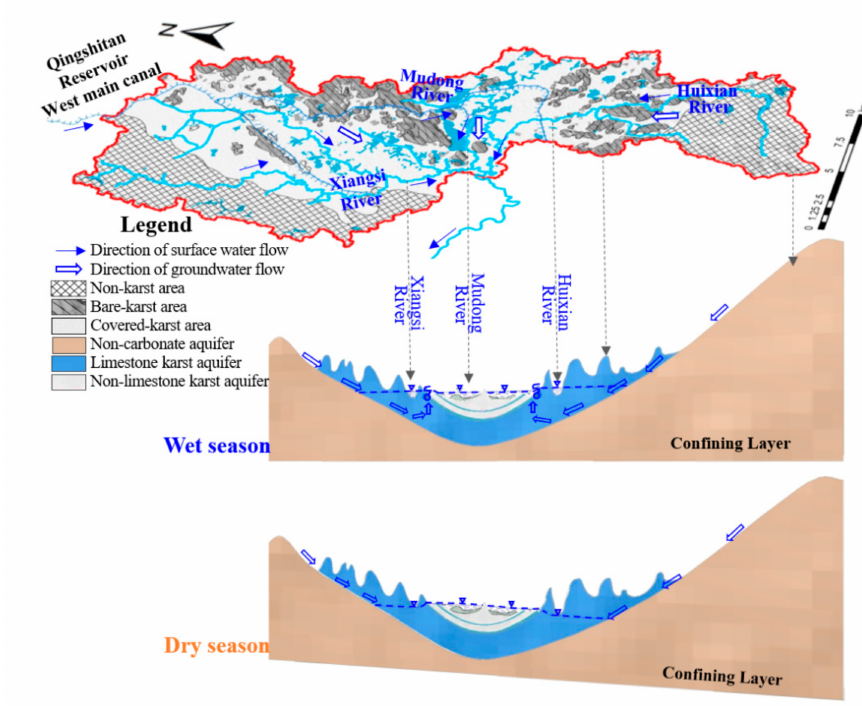
Figure 11. The interaction and conversion relationship of surface–underground water during wet season and dry season in Huixian karst